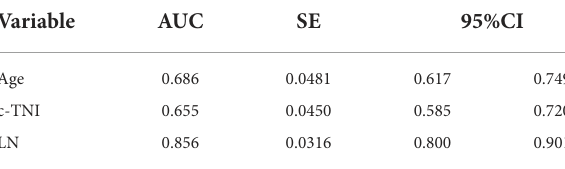
TABLE 3 Receiver operating characteristic curves for laminin, age, and c-TNI in the prediction of MACE in AMI patients. Variable